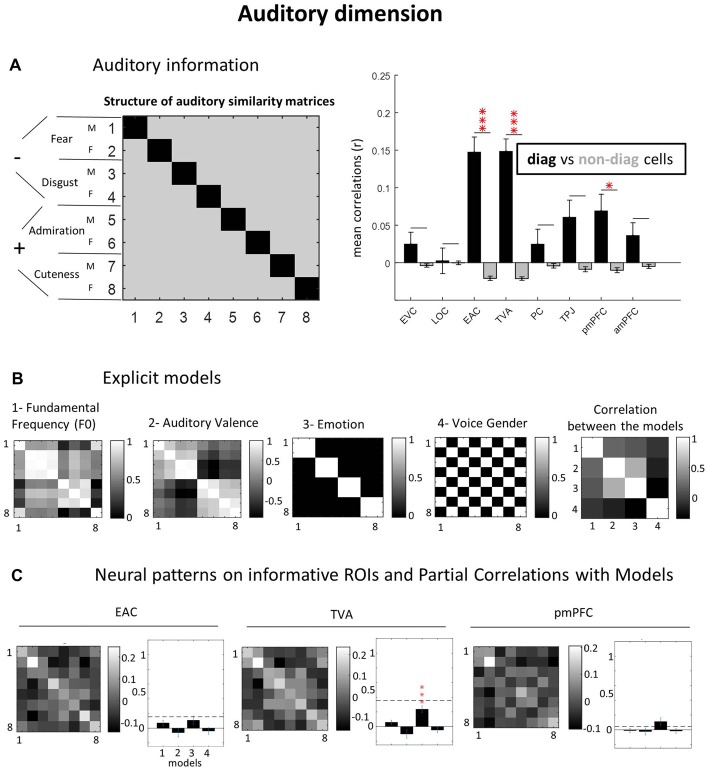
Auditory dimension. (A) Auditory information. (B) Explicit models. (C) Neural patterns on informative ROIs and partial correlations with models. As for the visual domain, we created for the auditory dimension, an “auditory GLM” declaring the eight auditory conditions, and then applying correlation-based MVPA. Models were built based on Fundamental Frequency (F0), group average auditory valence ratings, emotional content (fear, disgust, admiration and cuteness like) and voice gender. See caption of Figure 3 for equivalent explanation (C,D panels are collapsed here). *p = 0.05; ***p = 0.001 (Bonferroni-corrected).